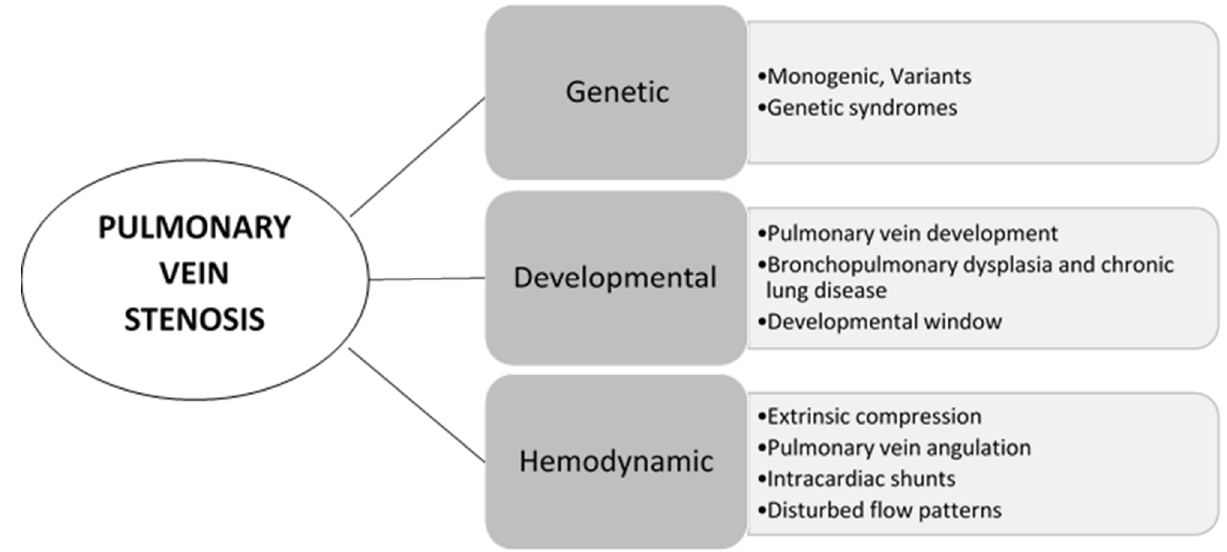
Figure 3. Modifying and contributing factors in pulmonary vein stenosis.